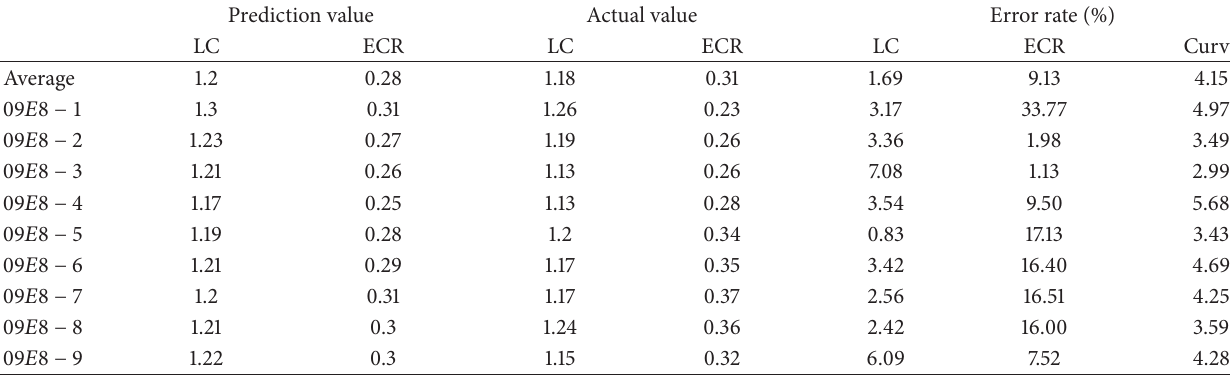
Table 2: Statistical predicted error rate of blast casting muck pile effect.